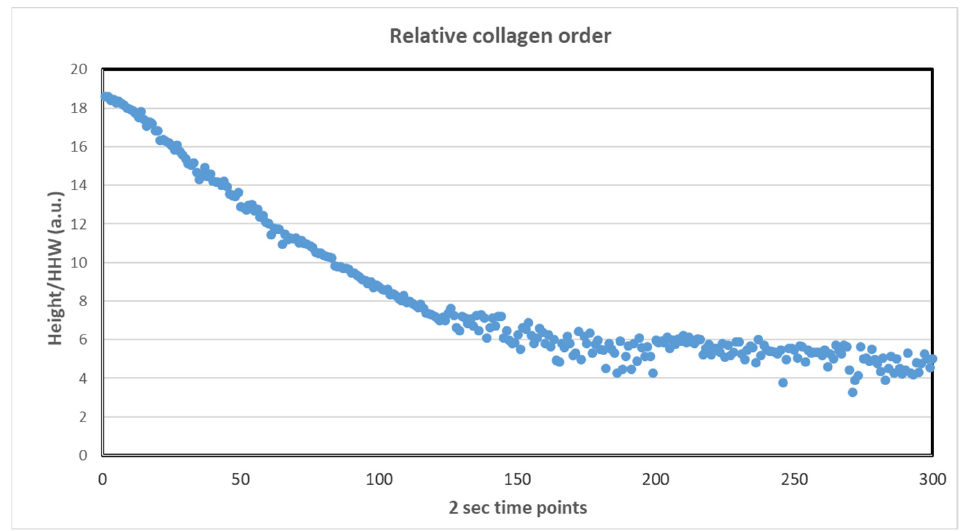
Figure 6. Height of the background-subtracted peak divided by peak width at half height (HHW) (arbitrary units, a.u.) versus the irradiation time (s).